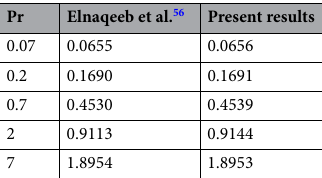
Table 1. Comparative analysis of